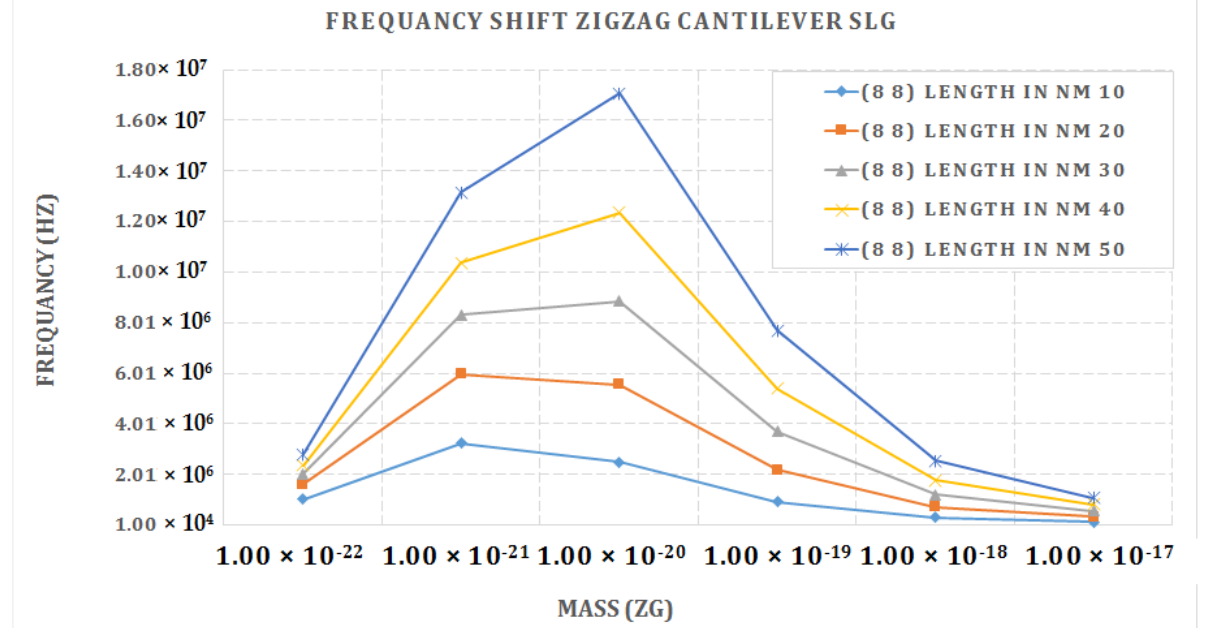
Figure 7. Frequency shift vs. attached mass graph of bridged chiral DLG (12, 4).